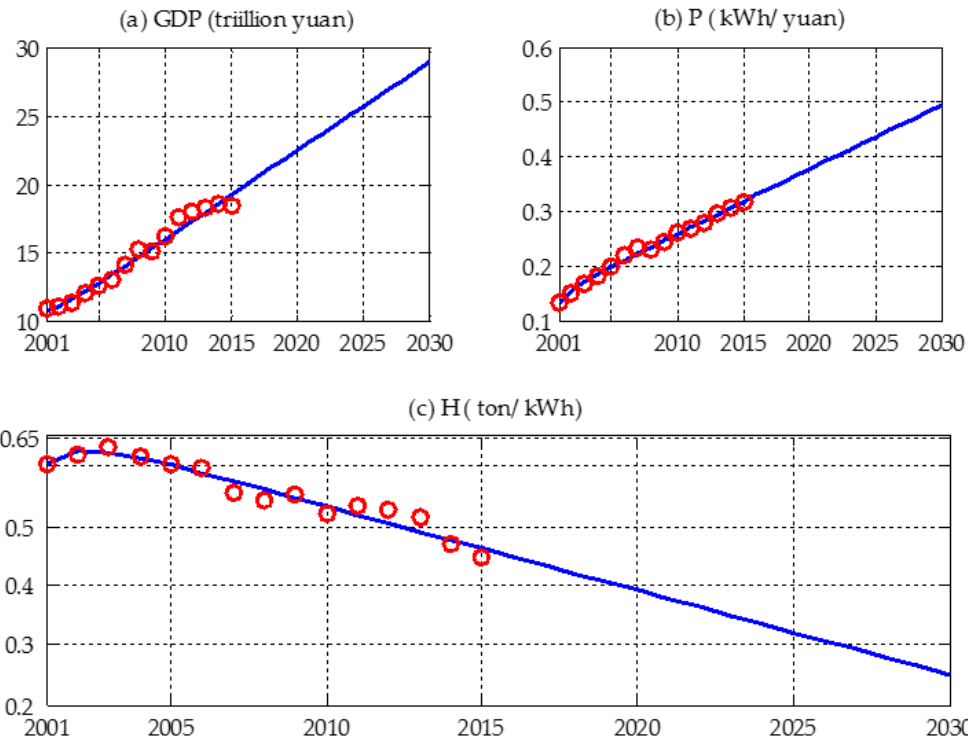
Figure 1. Fitting and forecasting results to the GDP, electric consumption per unit of GDP (P), and carbon emissions per unit of electricity